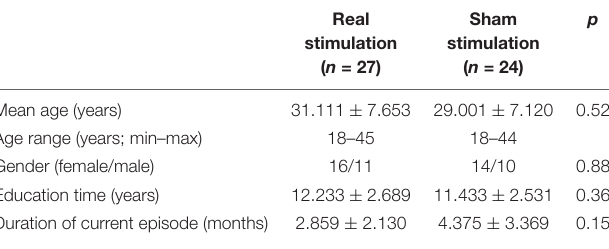
TABLE 1 | Demographic and clinical characteristics of the two